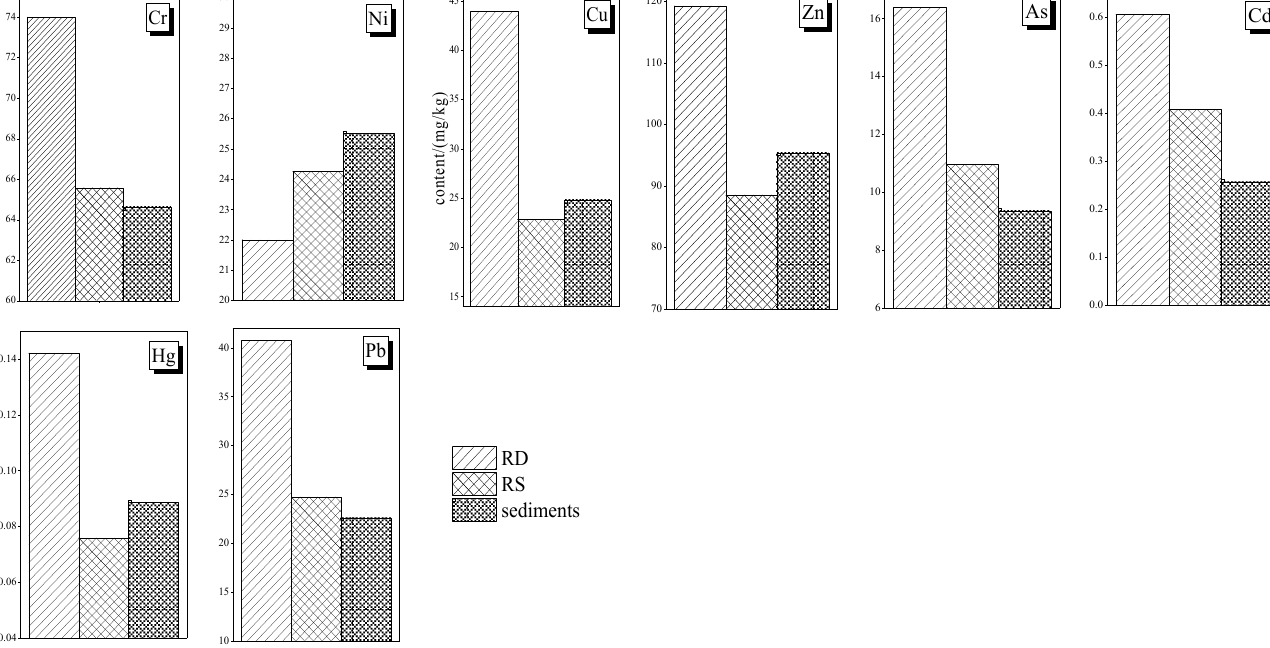
Figure 6. Mean concentration of di ff erent PTEs in road dust, roadside soil and surface sediment samples.